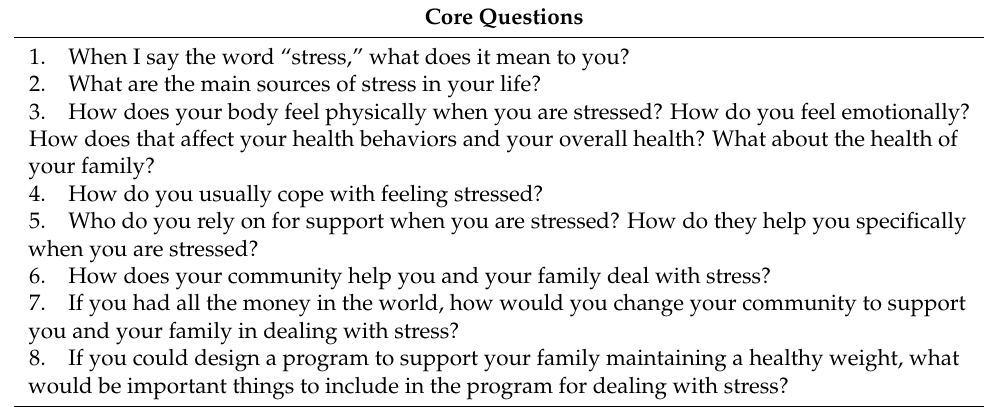
Table 1. Interview